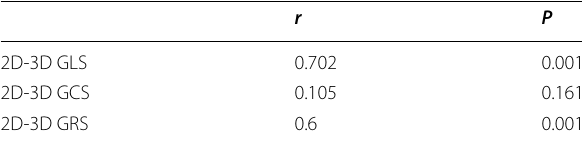
Table 5 r and P values of correlation among our study population 2D and 3D values of